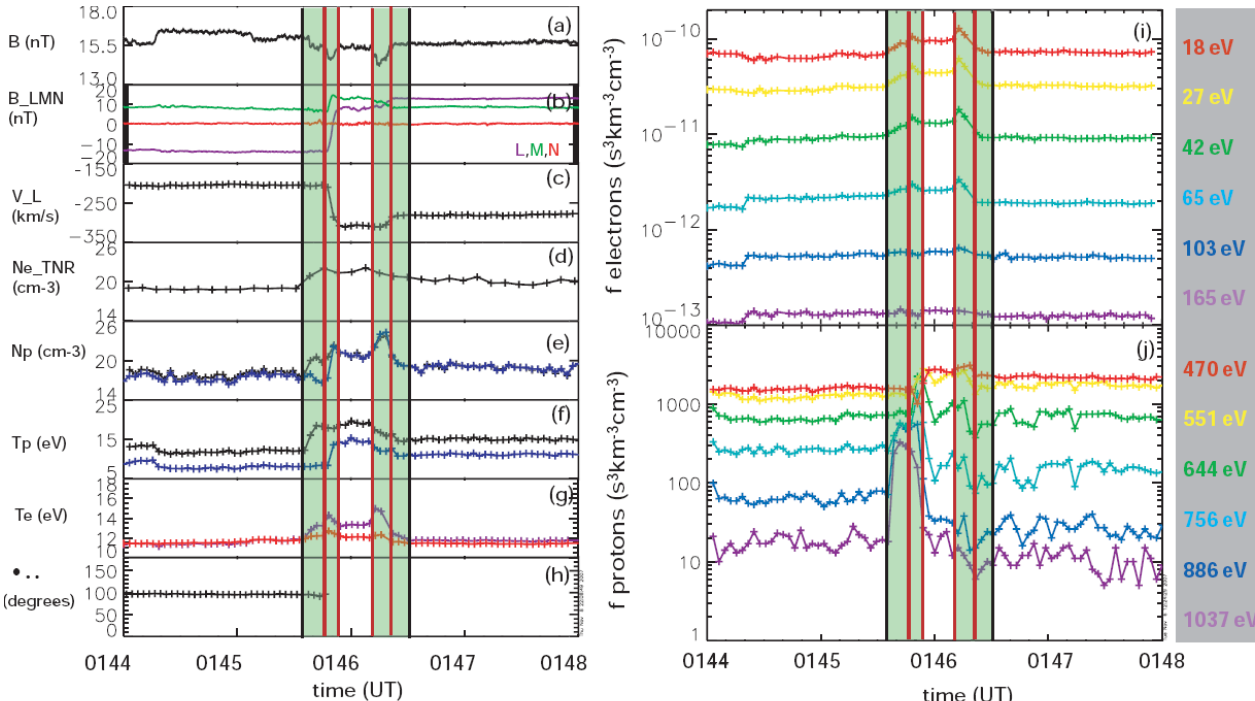
Fig. 2. Magnetic field and solar wind plasma measurements by the Wind satellite during a reconnection event on 22 July 1999. The panels on the left show: (a) the magnetic field strength, (b) the magnetic field components in the LMN -coordinate system, (c) the solar wind velocity in the L -direction, (d) the electron density from the TNR instrument, (e) the proton density, calculated on-board (blue line) and integrated from the 3-D distribution functions (black line), (f) the proton temperature, calculated on-board (blue line) and integrated from the 3-D distribution functions (black line), (g) the electron temperature parallel (purple line) and perpendicular (red line) to the magnetic field, and (h) the angle θ BN between the magnetic field and the model bow shock normal. The panels on the right show: (i) the electron phase space densities, transformed into the solar wind rest frame and integrated over all pitch angles, from 18 to 165eV, and (j) the proton phase space densities from 470 to 1037eV, also transformed into the solar wind rest frame and integrated over all pitch angles. The estimated locations of the separatrices are indicated by the black vertical lines, and the current sheet crossings are delimited by the two pair of red lines. The outflow region is confined between two innermost red